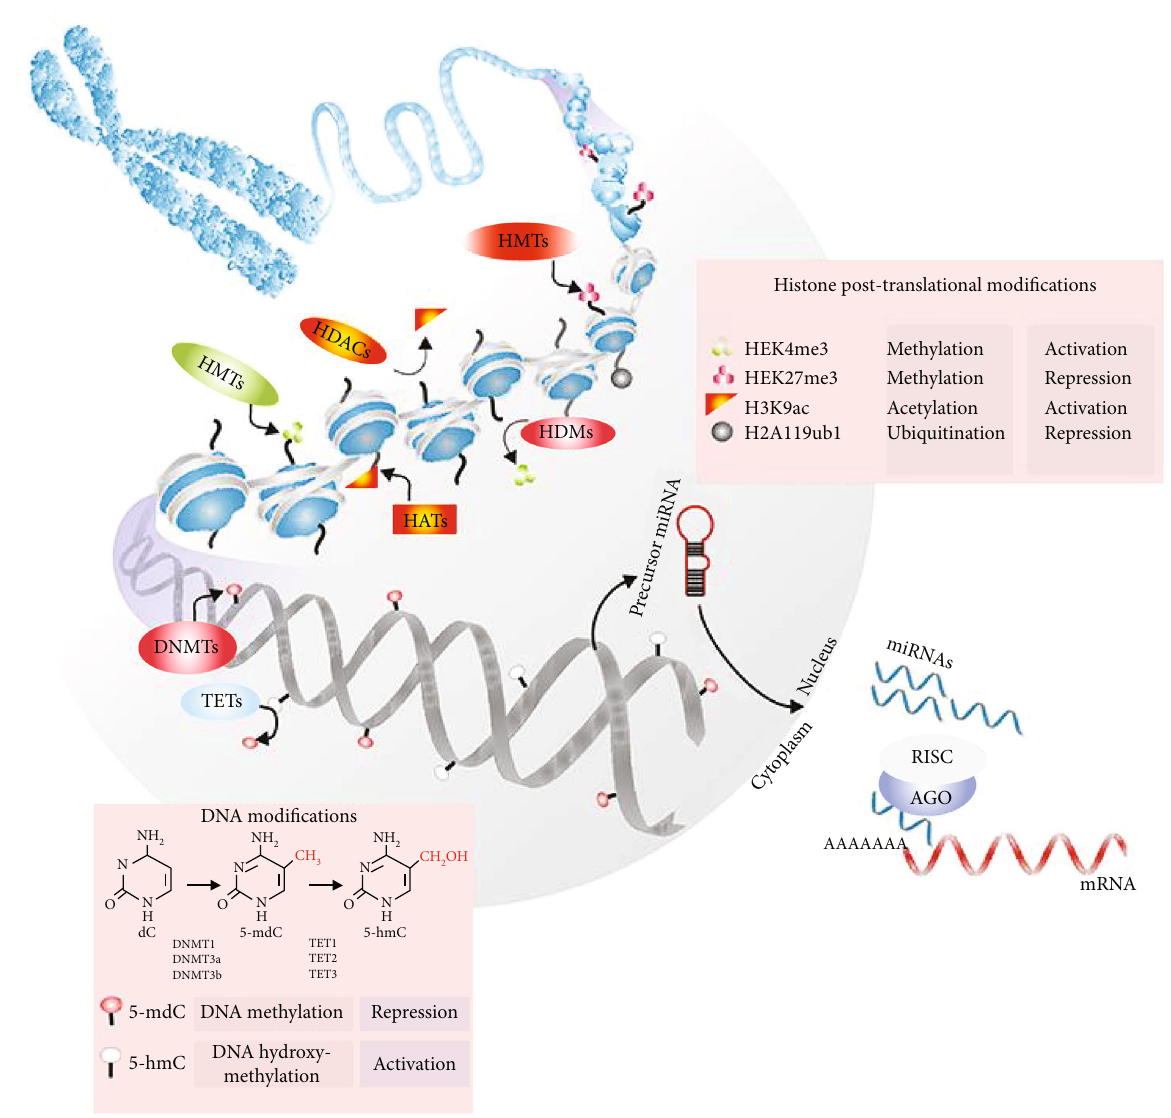
Figure 1: DNA methylation, histone posttranslational modi fi cations (HPTMs), and ncRNAs are the most common epigenetic markers in chromatin remodeling and restructure. A methyl group (-CH3) attach to 5-methyl-deoxy-cytidine (5-mdC) by DNA methyltransferases (DNMTs). The family members of the ten-eleven translocations (TET) can remove DNA methylation marks by converting 5-mdC to 5- hydroxymethylcytosine. Histone methyltransferases and HDACs have been shown to regulate cell methylated, acetylated, and ubiquitinated histone patterns. mRNA can be repressed during transcriptional repression by ncRNAs, such as miRNAs. The Dicer breaks down miRNA precursors in the cytoplasm, and the miRNA is then fi lled and attached to mRNA targets. Inhibition, degradation, and/or destabilization of the miRNA-mRNA interactions depend on their base pairing